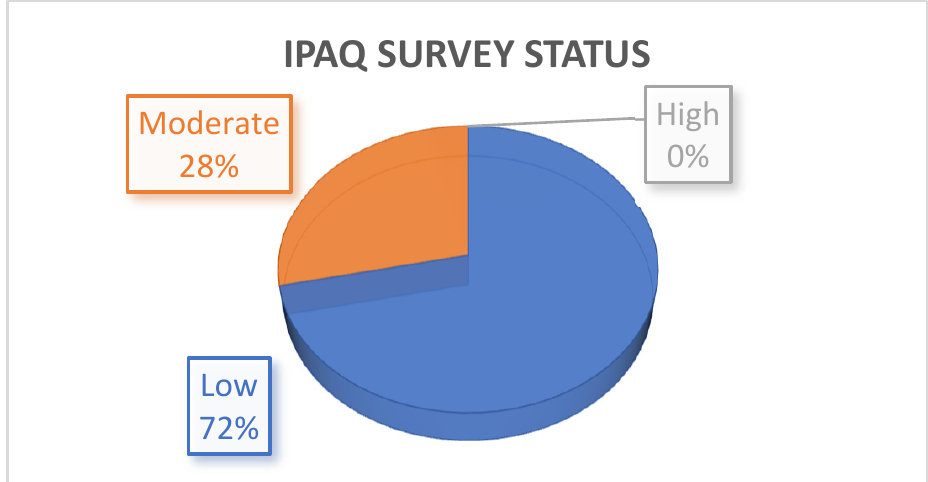
Figure 1. Level of physical activity according to the IPAQ survey.